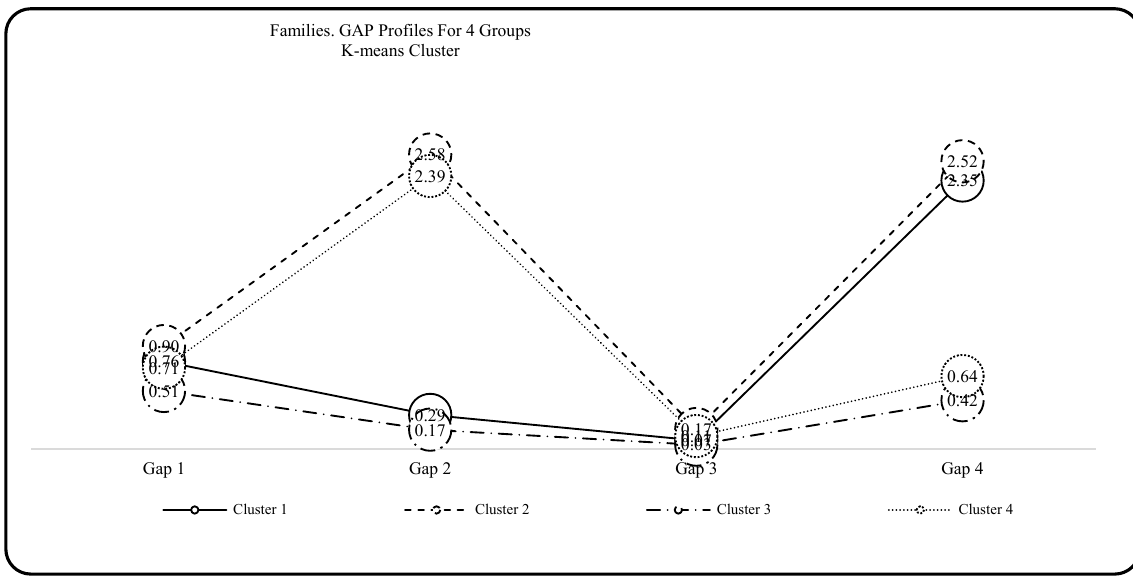
Figure 4. Gap profiles for four groups per k-means cluster.